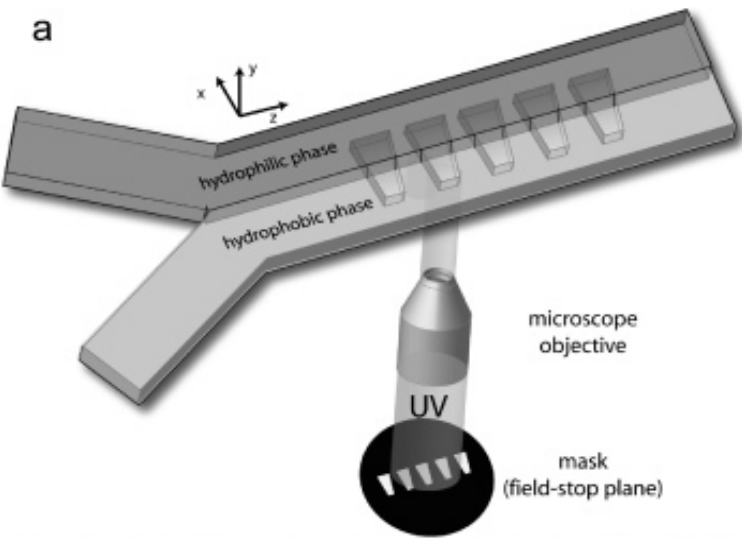
Figure 2. Schematic depicting the formation of biphasic particles. Mask-defined wedge shapes are polymerized, five at a time, across two parallel coflowing streams containing hydrophilic and hydrophobic chemistries using continuous flow lithography. (Reprinted with permission from [48]. Copyright 2007 American Chemical